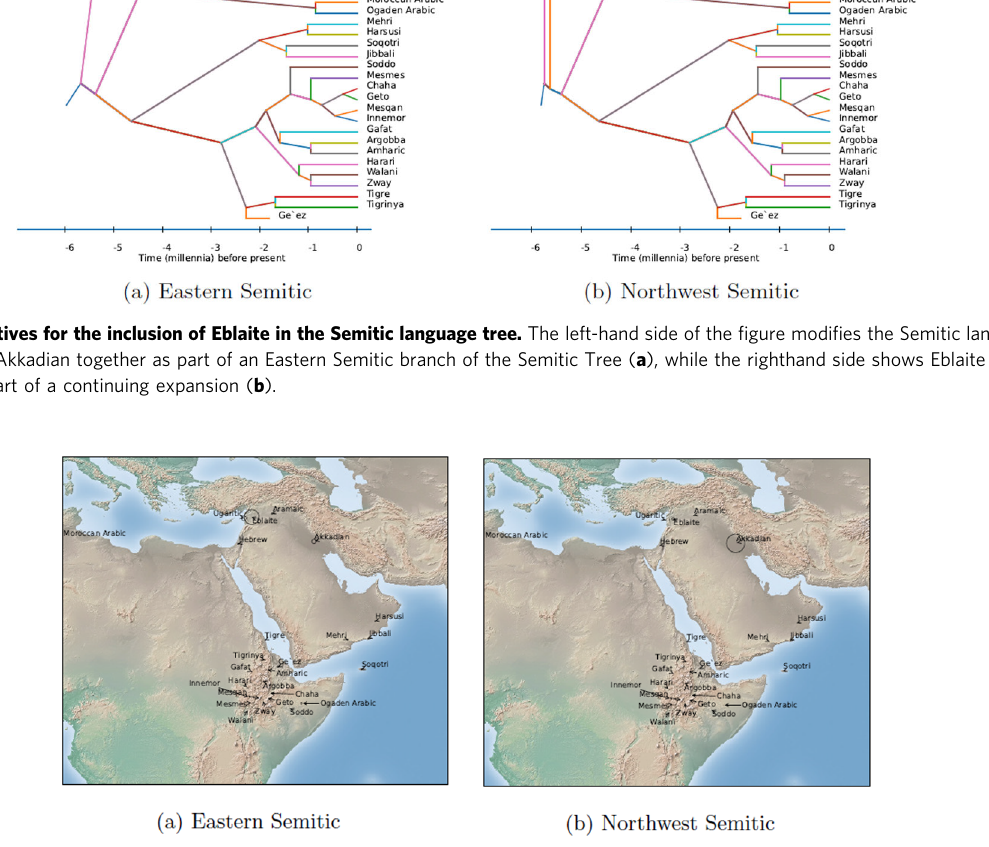
Fig. 11 Two theories of Eblaite. a Eastern Semitic, b Northwest Semitic. Circles are drawn in proportion to the likelihood of locations being the point of origin of the entire